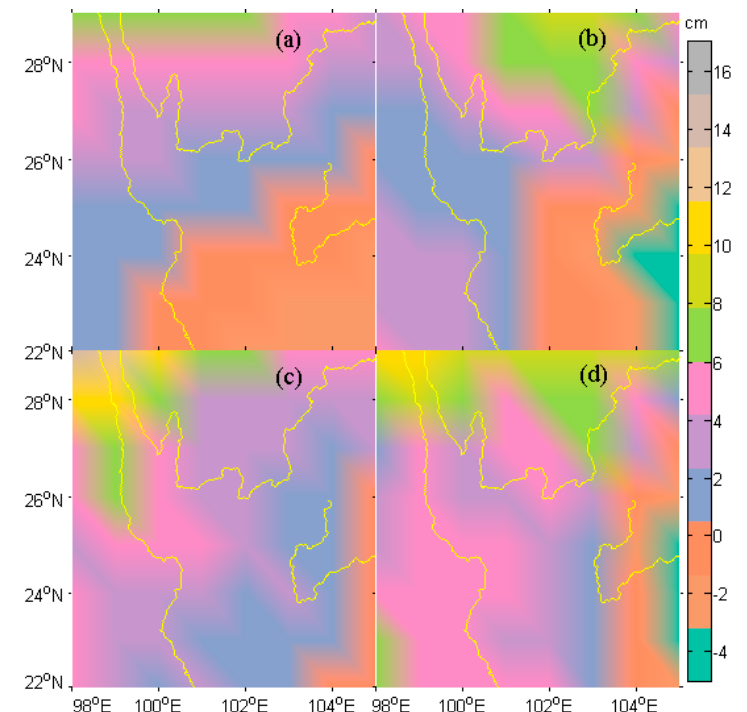
Figure 8. Differences between EWHs derived by different methods. ( a ) GPS(HVCE)-GRACE; ( b ) GPS(MMSE)-GRACE; ( c ) GPS(HVCE)-GLDAS; ( d ) GPS(MMSE)-GLDAS. GPS(MMSE)-GRACE; ( c ) GPS(HVCE)-GLDAS; ( d ) GPS(MMSE)-GLDAS.